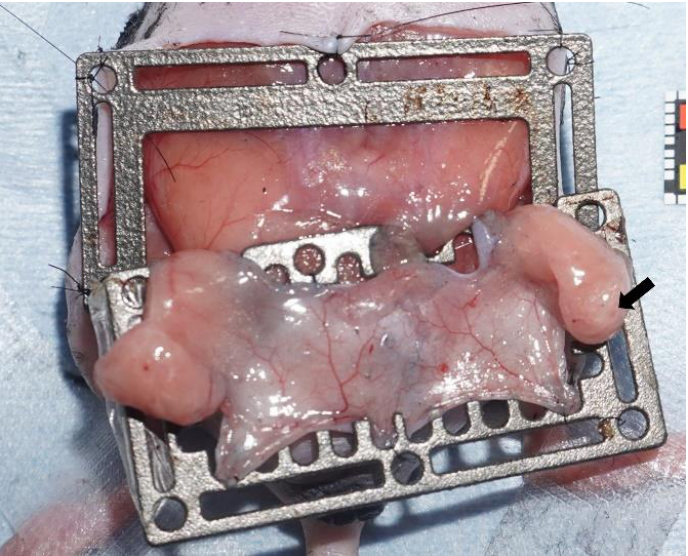
Figure 2. The flap was sutured to a metal frame, which was created using a 3D printer, to maintain a constant postoperative skin tension, prevent peripheral angiogenesis, and accurately measure the extent of the flap survival area for preventing angiogenesis from the surrounding skin.